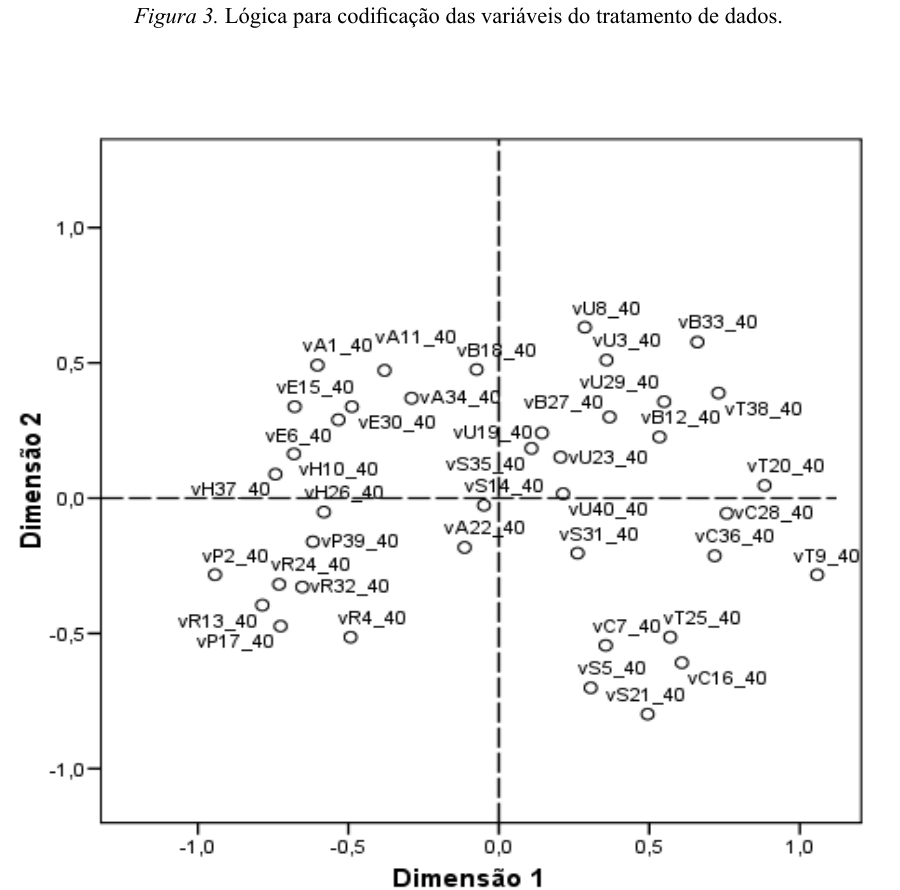
Figura 3. Lógica para codi fi cação das variáveis do tratamento de dados.